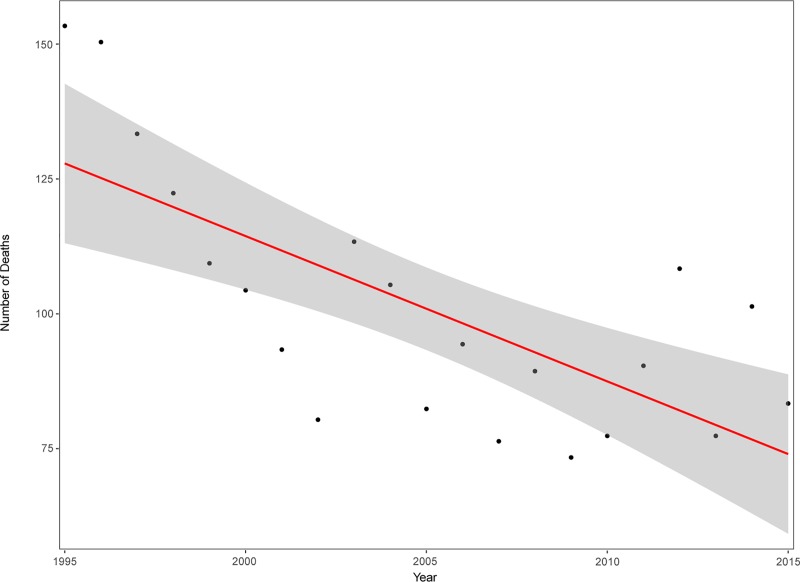
Trend in the number of fatal cases.The grey area depicts 95% CI, p<0.001.